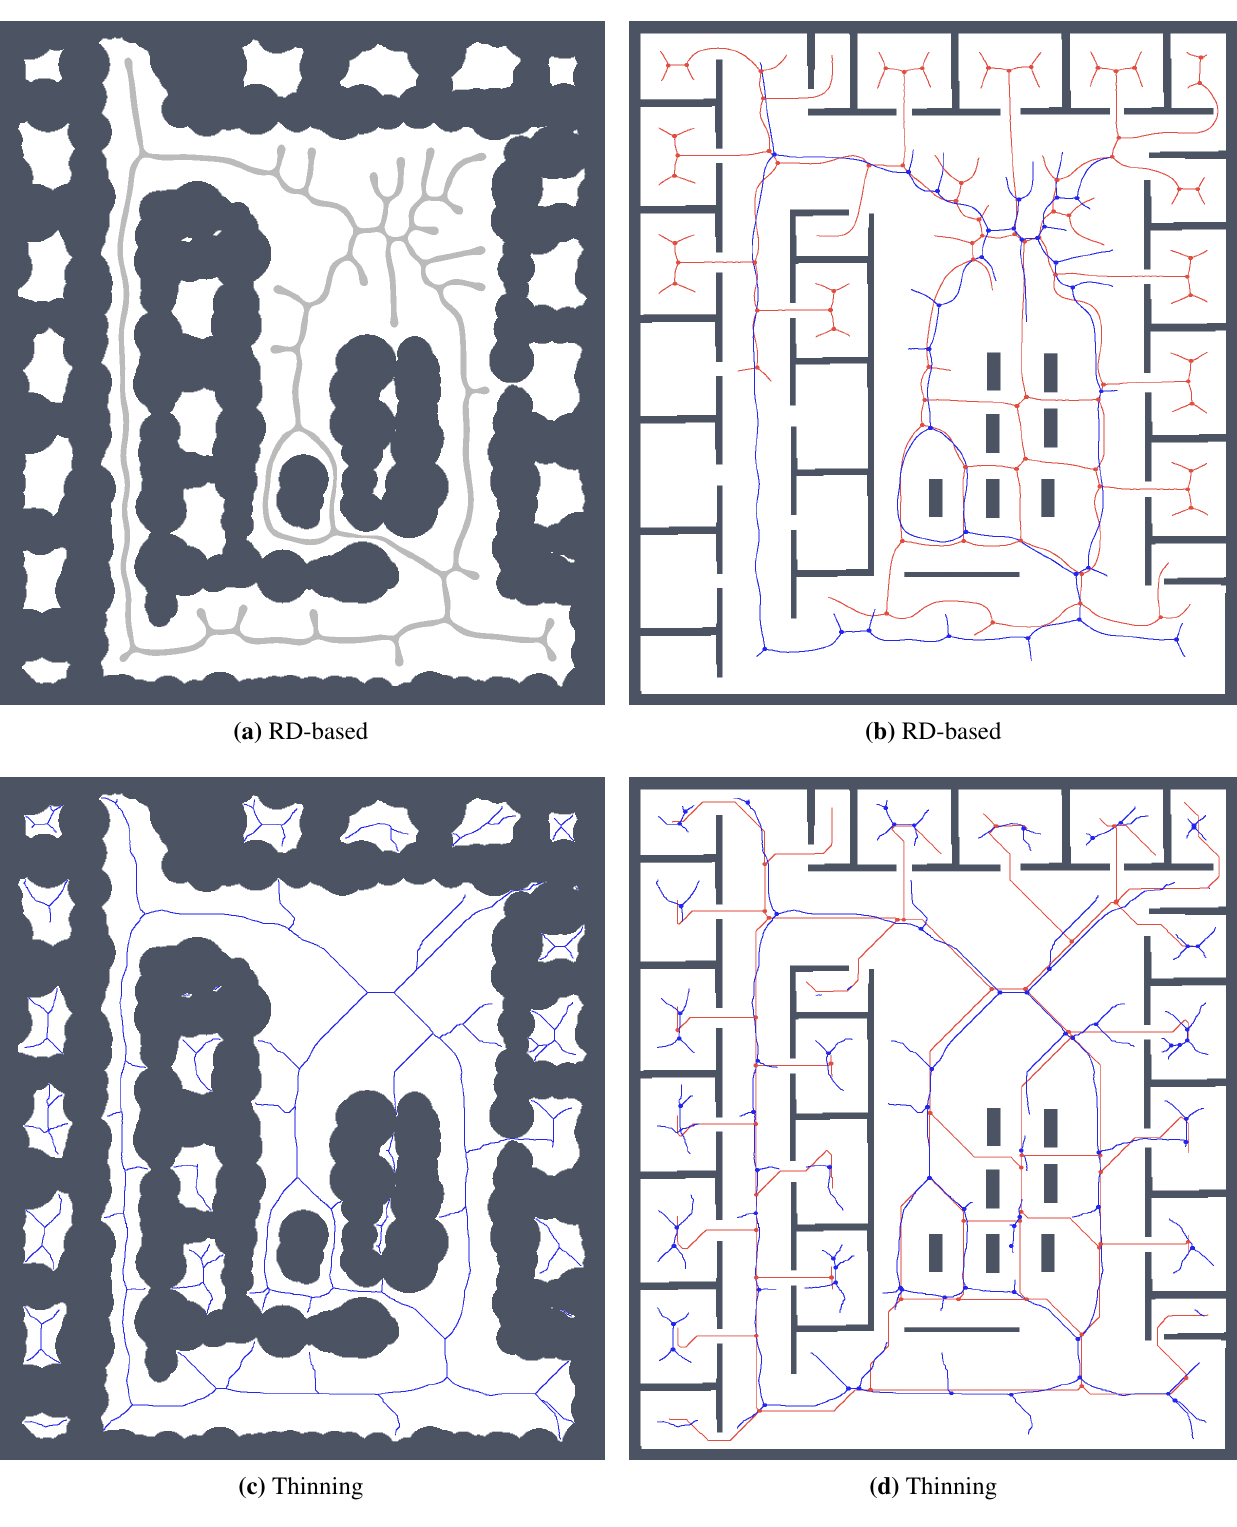
Figure 21. Determined skeletons and topological maps with highlighted junction places and leaves in the map jh with the noise level σ = 10 for the scaled map with 1280 × 1438 grid points: ( a ) RD-based Voronoi diagram; ( b ) and its corresponding skeleton superimposed on the skeleton determined in the noise-less map (in red); ( c ) Pruned GVG representing skeleton of the map determined by the thinning algorithm [12]; ( d ) and the corresponding skeleton superimposed on the skeleton determined in the noise-less